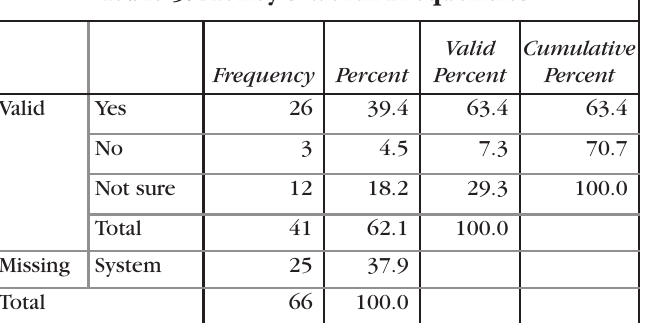
Table 5. Money’s Worth Frequencies